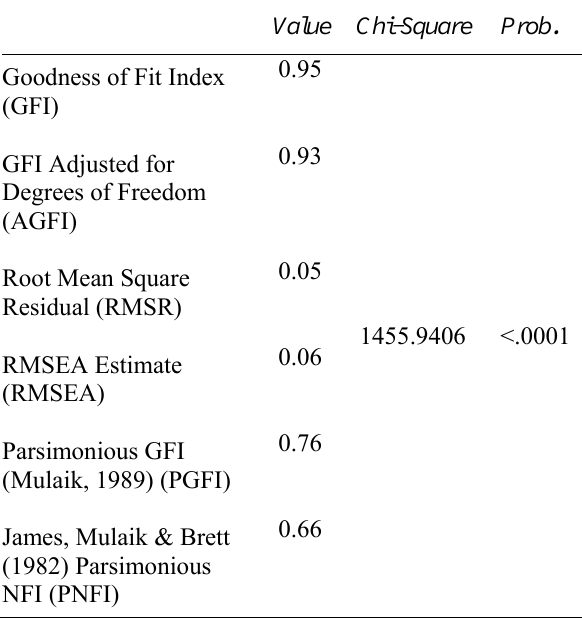
Table 5: Results of a Confirmatory Factor Analysis of the Four Factor CSI-SF Value Chi-Square